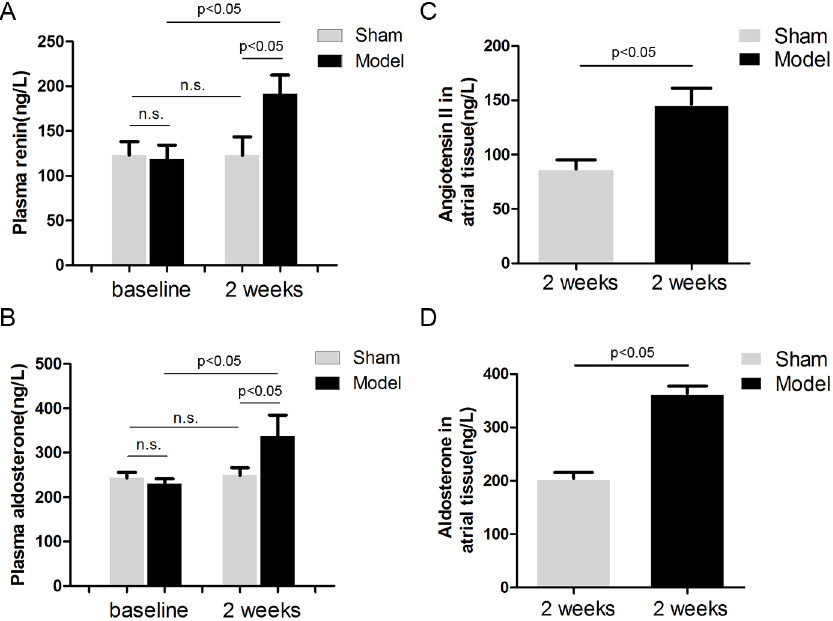
Figure 7. Effects of embolization versus sham operation on plasma renin (A) and aldosterone (B) levels, left atrial angiotensin II (C) and aldosterone (D) levels (n=5).